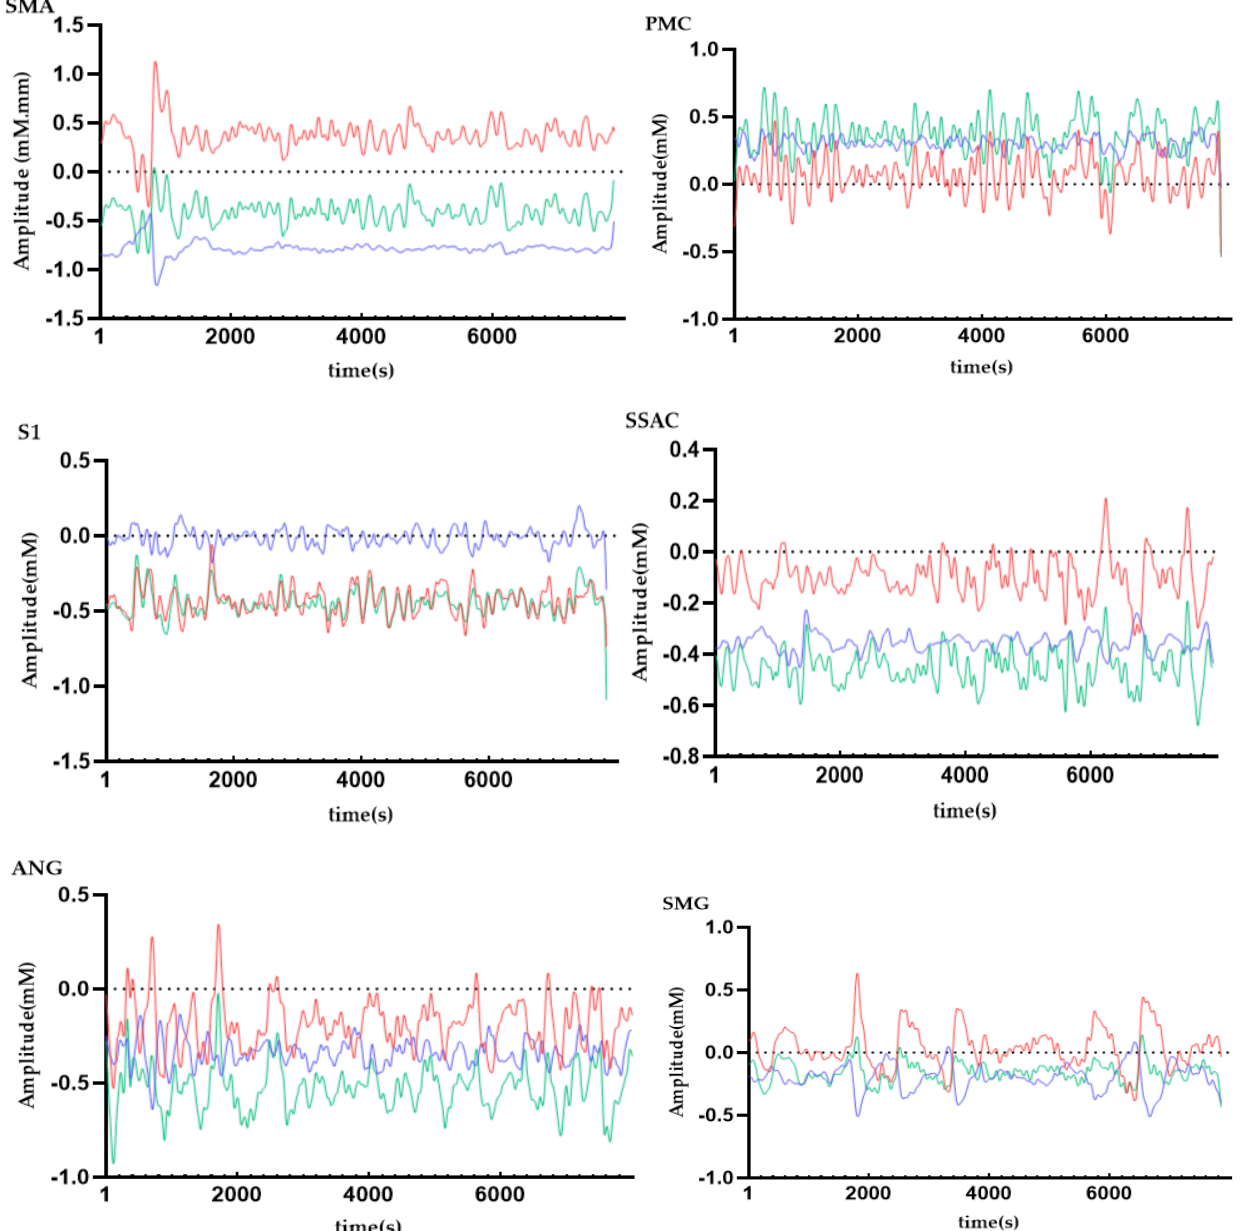
Figure 6. Time series of hemodynamic response for HbO (red line), HbR (blue line), and HbT (green line) across all subjects FAbbreviations: SMA = supplementary motor cortex; PMC = primary motor cortex; S1 = primary somatosensory cortex; SSAC = somatosensory association cortex; ANG = angular gyrus; SMG = supramarginal gyrus.